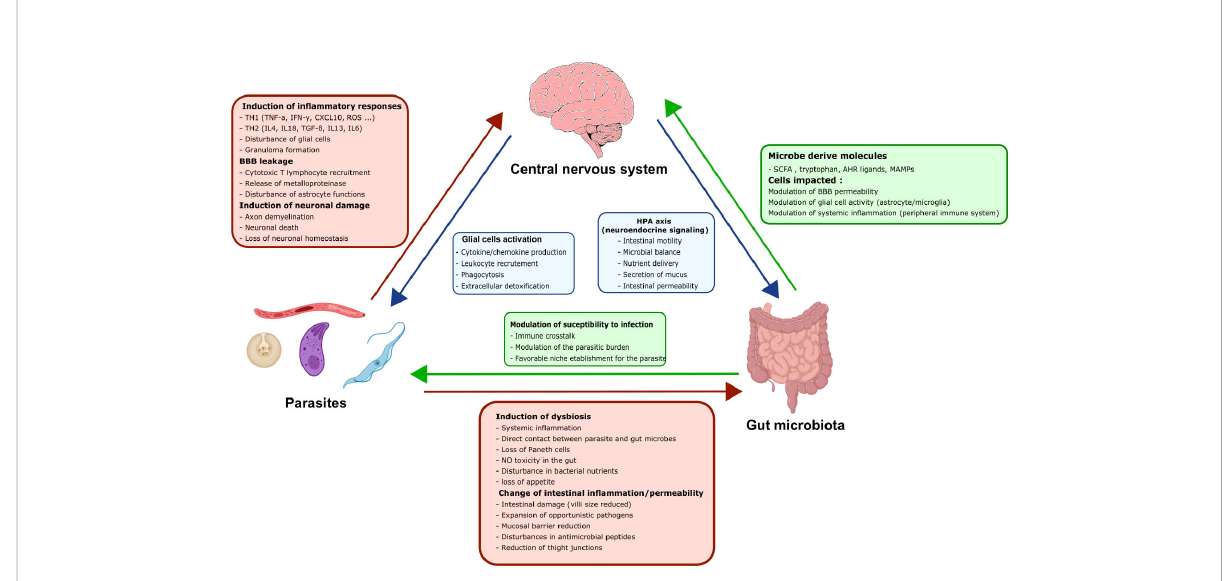
FIGURE 5 The three-way dialogue between parasites, the gut microbiota, and glial cells. A complex bidirectional dialogue exists between the gut microbiota, the CNS and the parasite. Green boxes and arrows summarize gut microbiota interactions with the CNS and the parasites. Red boxes and arrows represent parasites interactions with the CNS and the gut microbiota. Blue boxes and arrows indicate CNS interactions with the gut microbiota and the